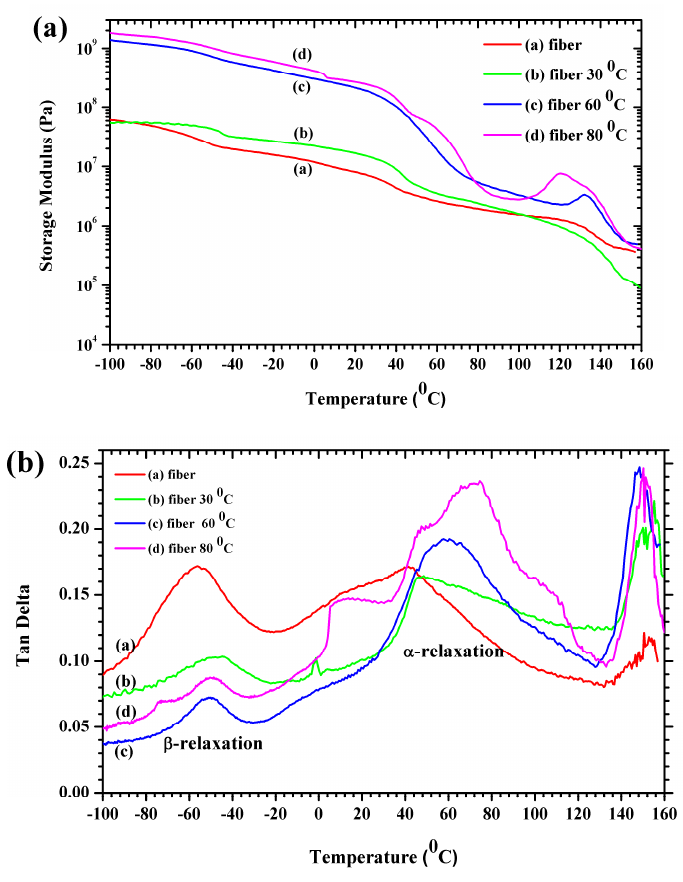
Figure 6. The dynamic mechanical analysis curves of P(VDF-HFP) fiber and compressed fiber mats. ( a ) Storage modulus and ( b ) tan delta.